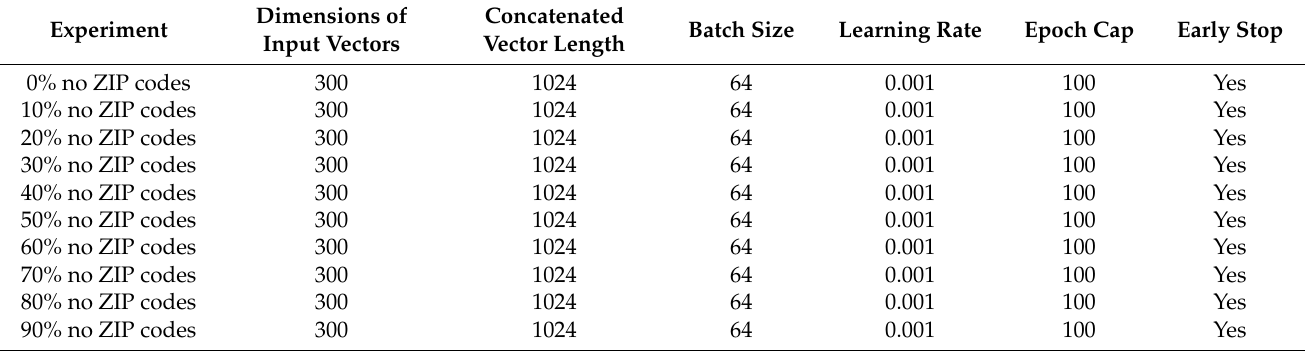
Table A6. Hyperparameter settings for the